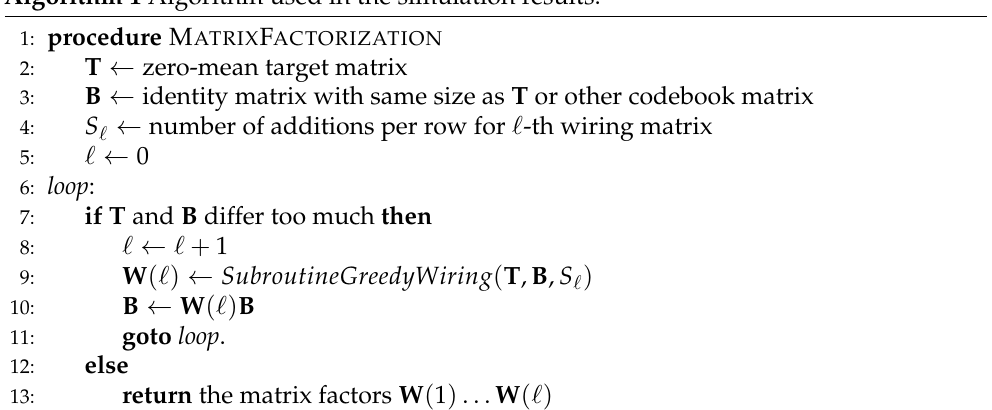
Algorithm 1 Algorithm used in the simulation